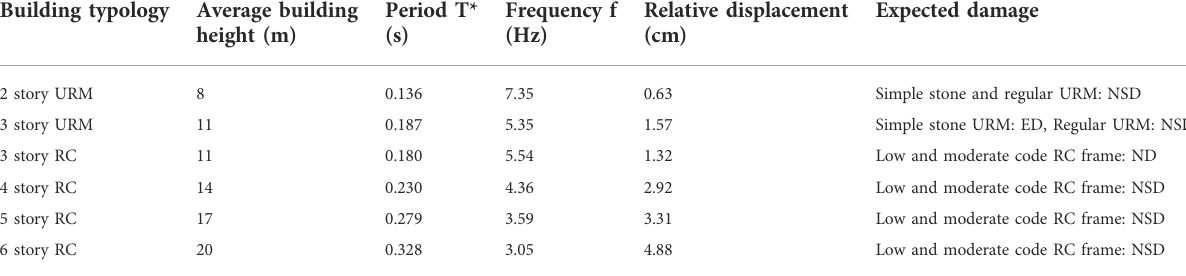
TABLE 2 Damage assessment for Amatrice for the most common building typologies (2-3 story URM and 3 – 6 story RC buildings).